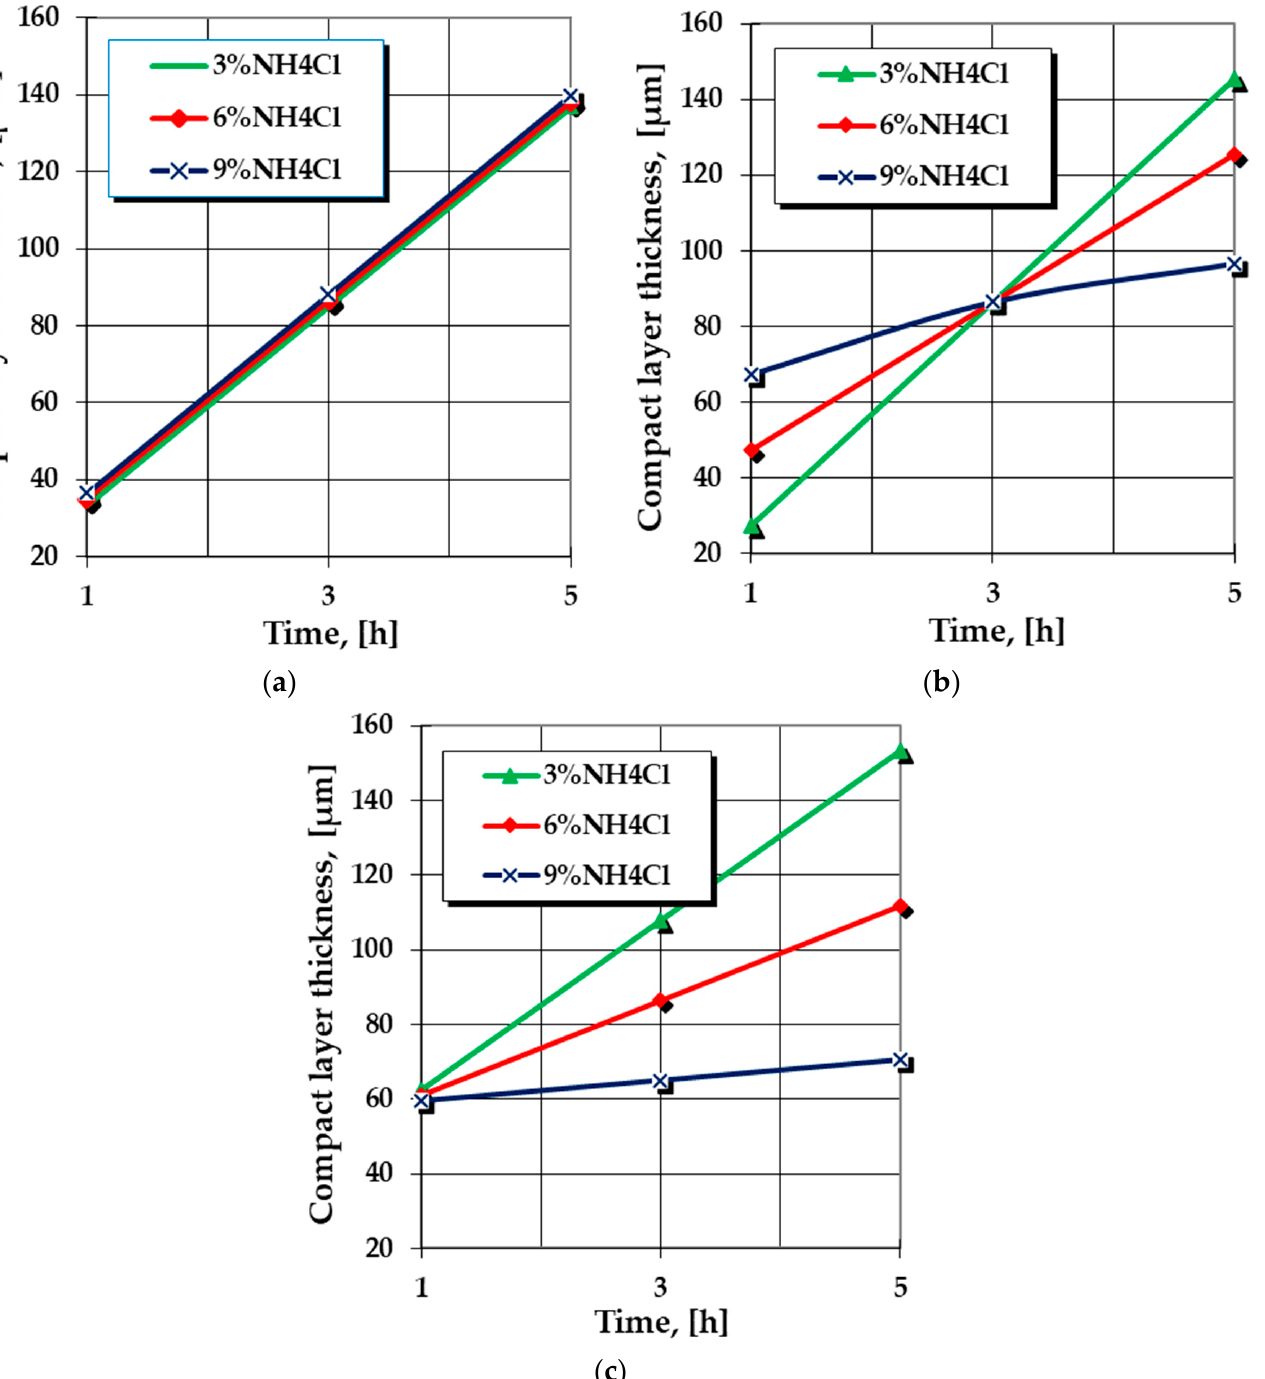
Figure 3. The change of growth kinetics of the silicon cemented layer (compact and adherent) is generated by the variation of the holding time on temperature, the ferrosilicon (FeSi75C) proportion, and the ammonia chloride in the powdered solid mixture utilized. ( a ) T = ct = 1050 °C; %FeSi = ct = 40%; ( b ) T = ct = 1050 °C; %FeSi = ct = 50%; ( c ) T = ct = 1050 °C; %FeSi = ct = 60%.